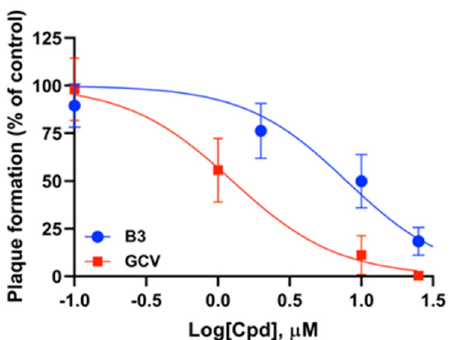
Figure 5. Inhibition of AD169 replication by B3 in PRA. Dose-response curves for B3 ( blue ) or GCV ( red ) were obtained by infecting HFF cells with HCMV AD169 and then treating them with different concentrations of the indicated compounds. Data shown are the means ± standard deviation of the mean relative to four independent experiments performed in duplicate.